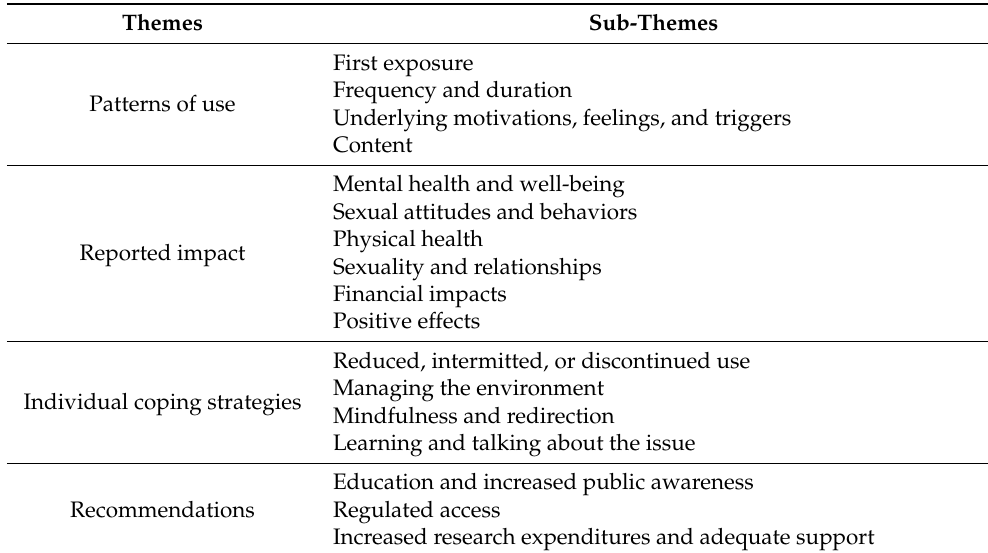
Table 1. Summary of themes and sub-themes.